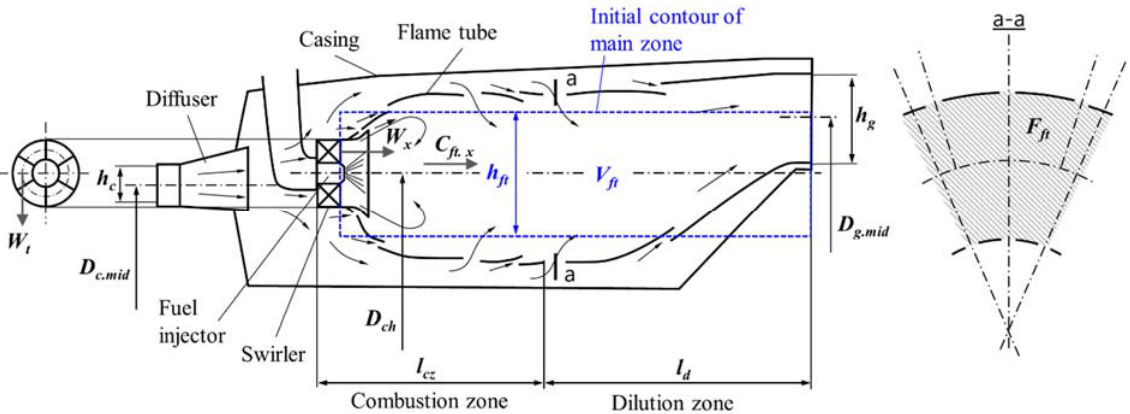
Figure 1. Schematic illustration of single annular combustor [23,24].